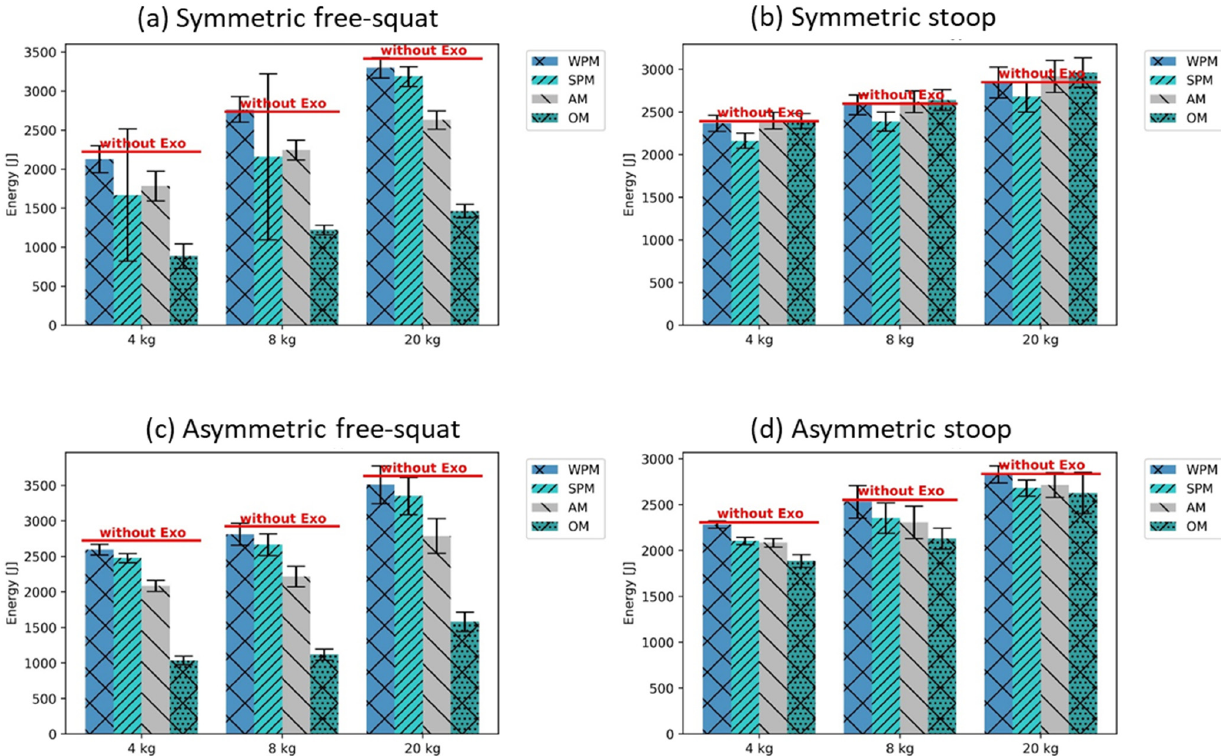
Figure 9. Metabolic costs with the different exoskeleton support modes (±SD), compared to the reference as mean without exoskeleton support.